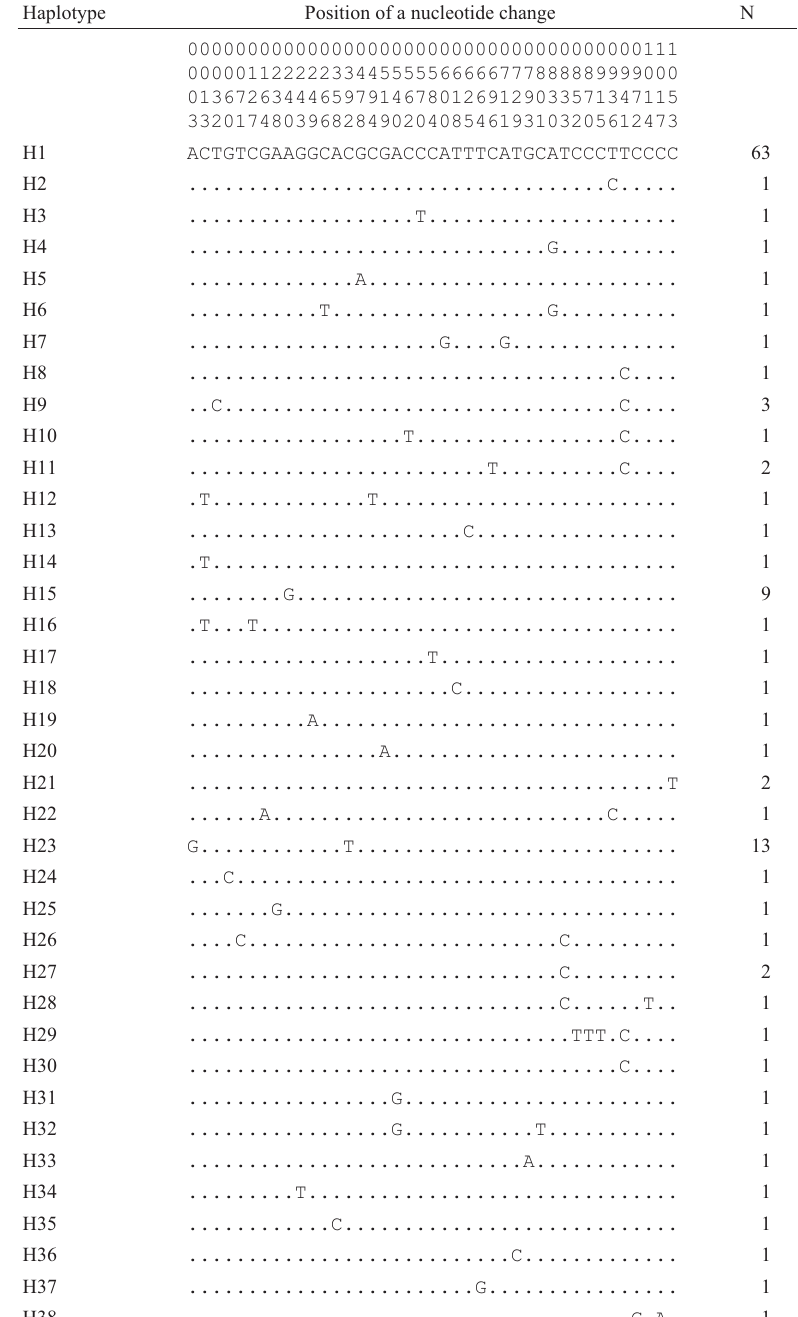
Table 1 - Variable sites in the 1085 bp fragment of the mitochondrial cytochrome b gene of Caiman crocodilus . A total of 41 sites were variable resulting in 38 haplotypes. N indicates the number of individuals in which a particular haplotype was found. Haplotypes are deposited in GenBank under accessions numbers DQ246626 to